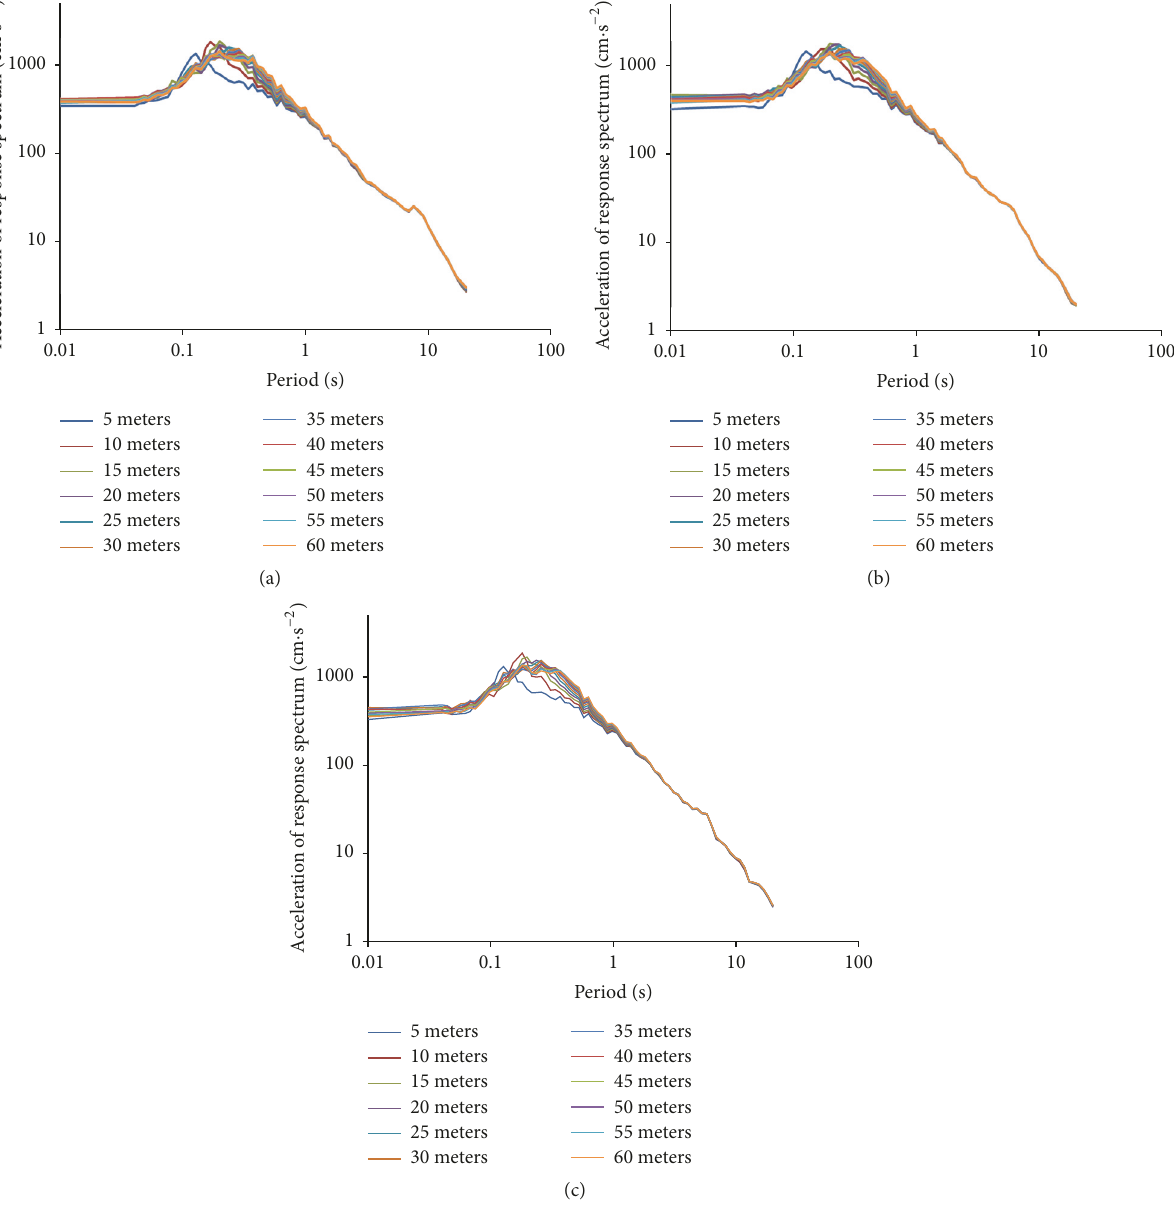
the increase of the soil layer depth, while the growth rate decreases with the increasing overburden thickness. The variation law of the characteristic periods with the loess thick- ness, presenting the logarithmic variation characteristics, can be fitted by (3), and the 𝑅 -square is 0.9935 ∘